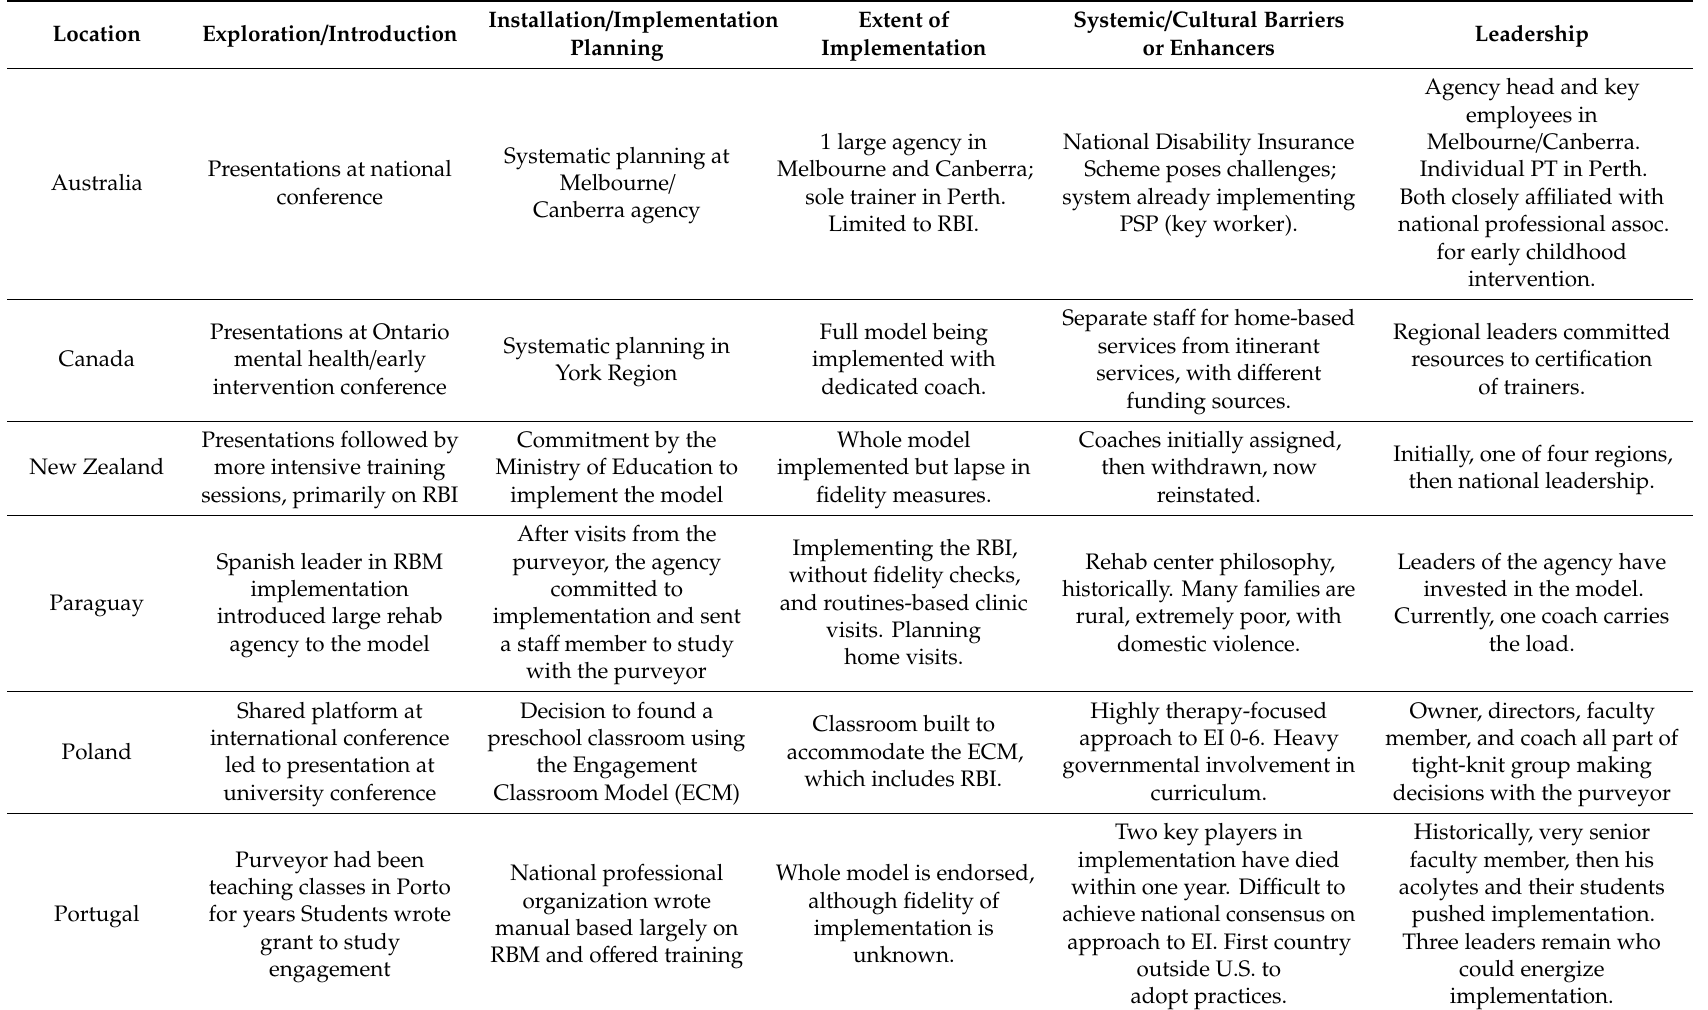
Table 1. Stages of Implementation by